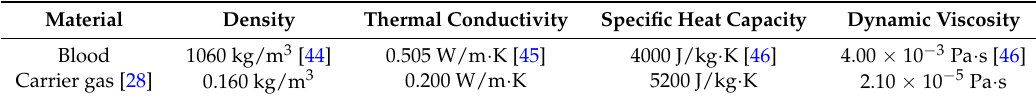
Table 1. Summary of material properties used in the present work.